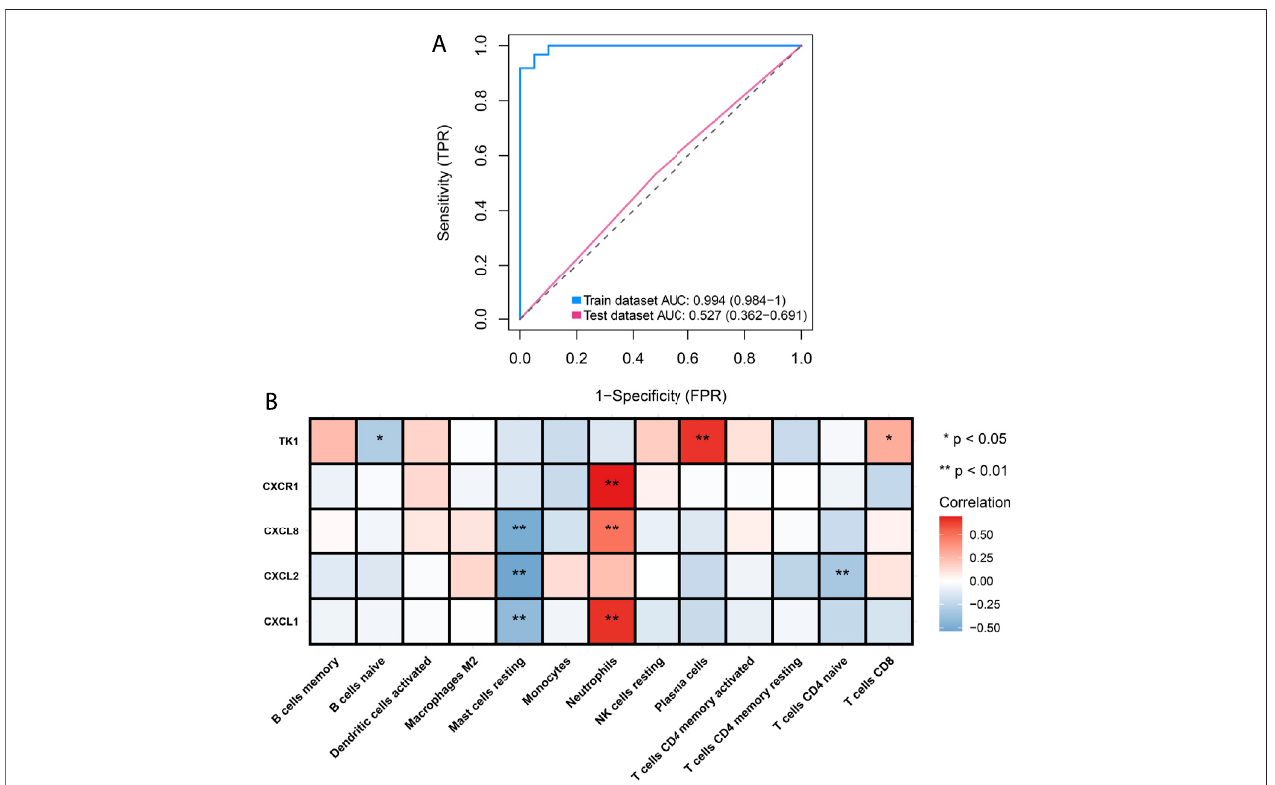
FIGURE5 | Analyses ofdiagnostic ef fi cacy ofthe LASSO model and associationsof characteristic geneswithin fi ltrating immune cells. (A) ROCs for evaluating the diagnosticef fi cacyoftheLASSOmodelbothintheGSE50772andGSE81622datasets. (B) Heatmapdepictstheassociationsofcharacteristicgenes(CXCL1,CXCL2, CXCL8, CXCR1 and TK1) with in fi ltrating immune cells in the GSE50772 dataset. * p < 0.05; ** p <